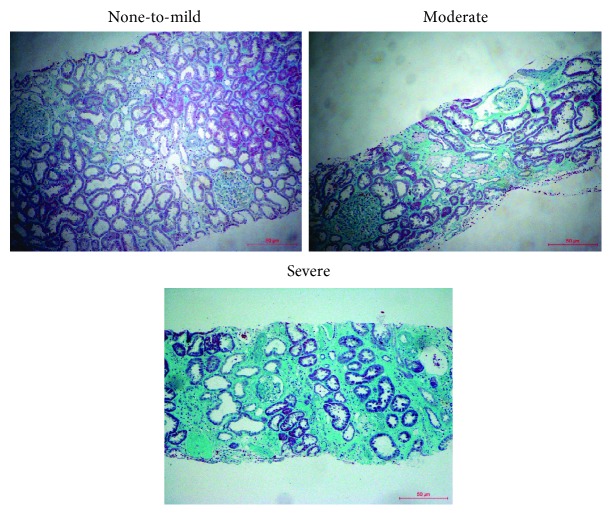
Representative histological findings of renal fibrosis stained by Masson's trichrome. None-to-mild fibrosis was considered as up to 25% of the tubulointerstitial fibrosis (TIF) area, moderate referred to an area 26%-50% of the TIF area, and severe referred to an area > 50% of the TIF area. Original magnification: ∗100.